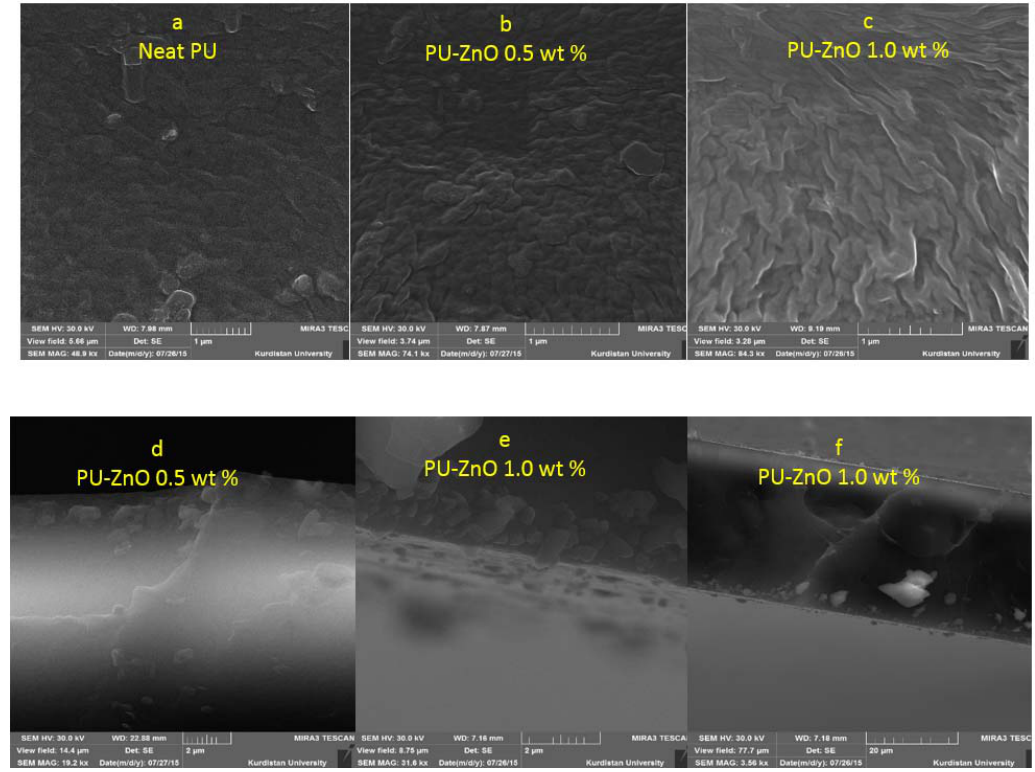
Figure 2. SEM surface images of MMMs ( a ) neat PU; ( b ) PU ‐ ZnO 0.5 wt %; ( c ) PU ‐ ZnO 1.0 wt % and cross section; ( d ) PU ‐ ZnO 0.5 wt %; ( e ) PU ‐ ZnO 1.0 wt %; ( f ) PU ‐ ZnO 1.0 wt %.